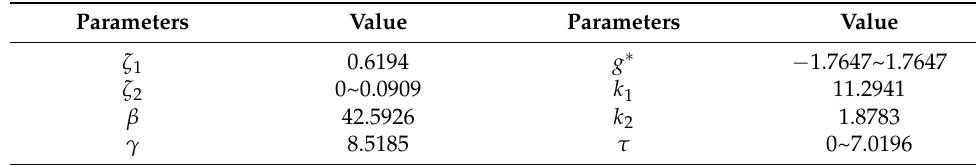
Table 3. Dimensionless model parameters. Parameters Value